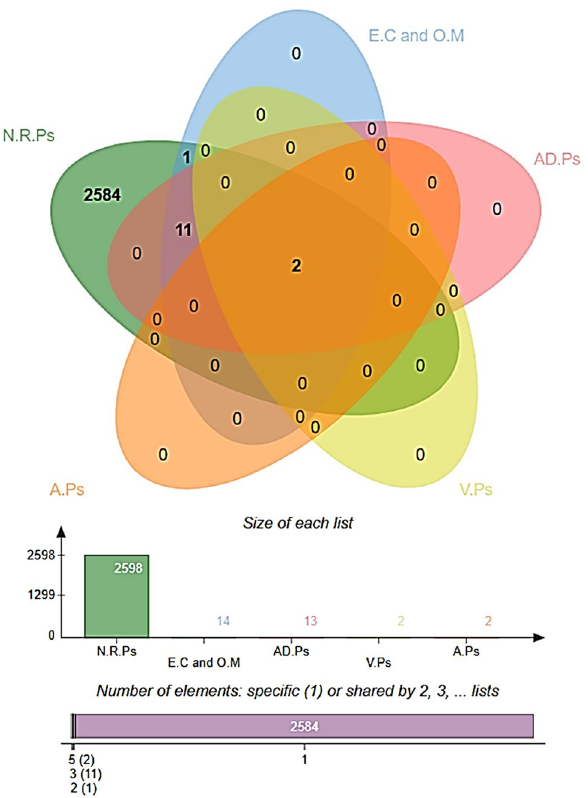
Figure 3. Prioritization of potential vaccine candidates using reverse vaccinology approach. The proteins selection is based on different vaccine parameters. N.R.Ps (non-redundant proteins), E.C (extracellular), O.M (outer membrane), AD.Ps (adhesive proteins), V.Ps (virulent proteins) and A.Ps (antigenic